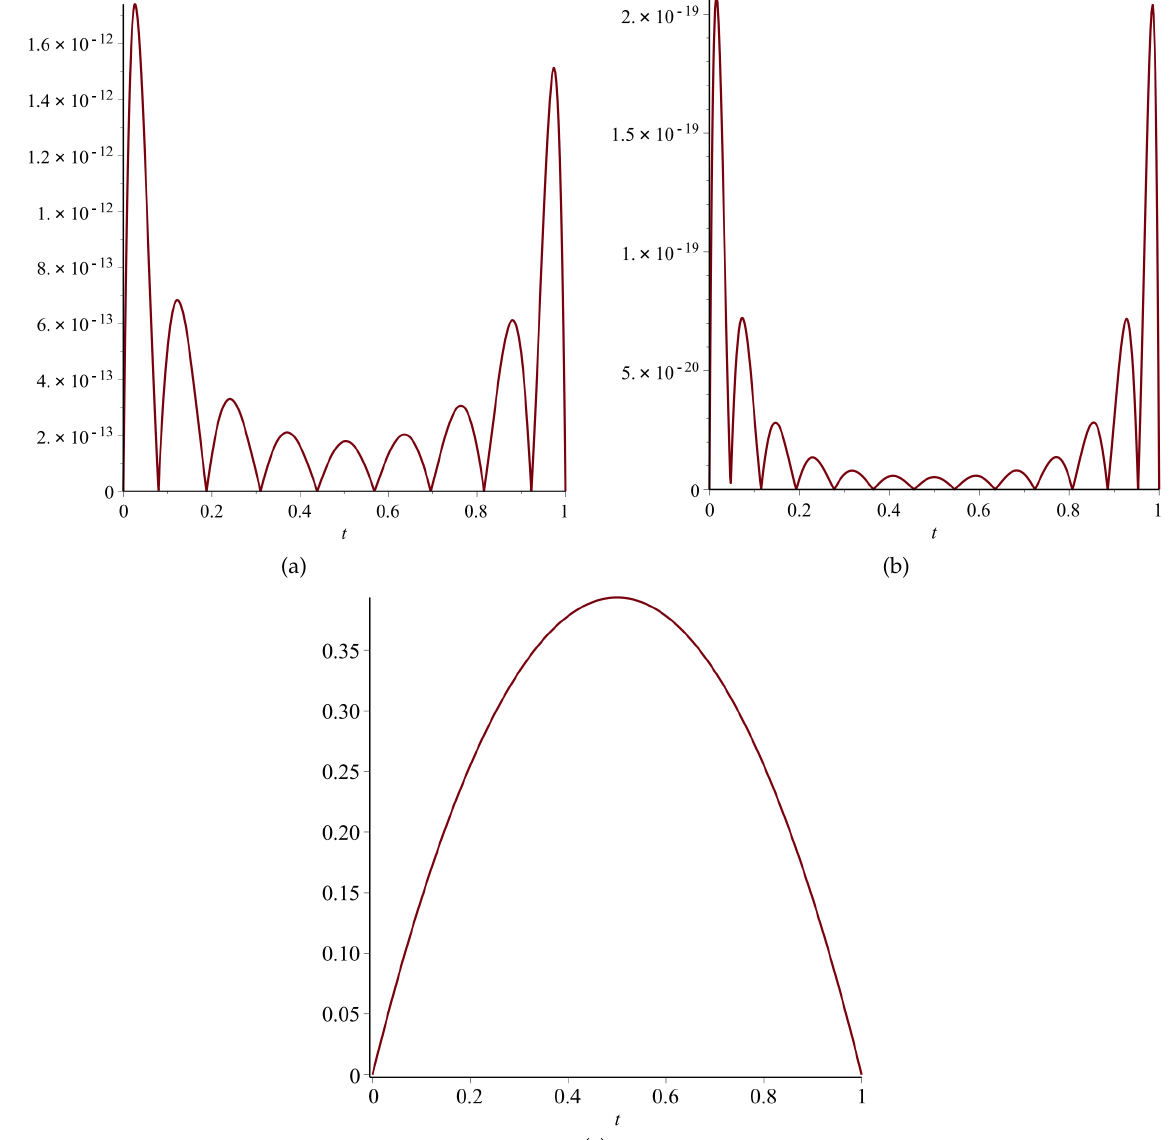
Fig. 1. The absolute errors | e N ( t ) | for n = 8 (a) and n = 12 (b) and (c) approximate solution u ( t ) of Example